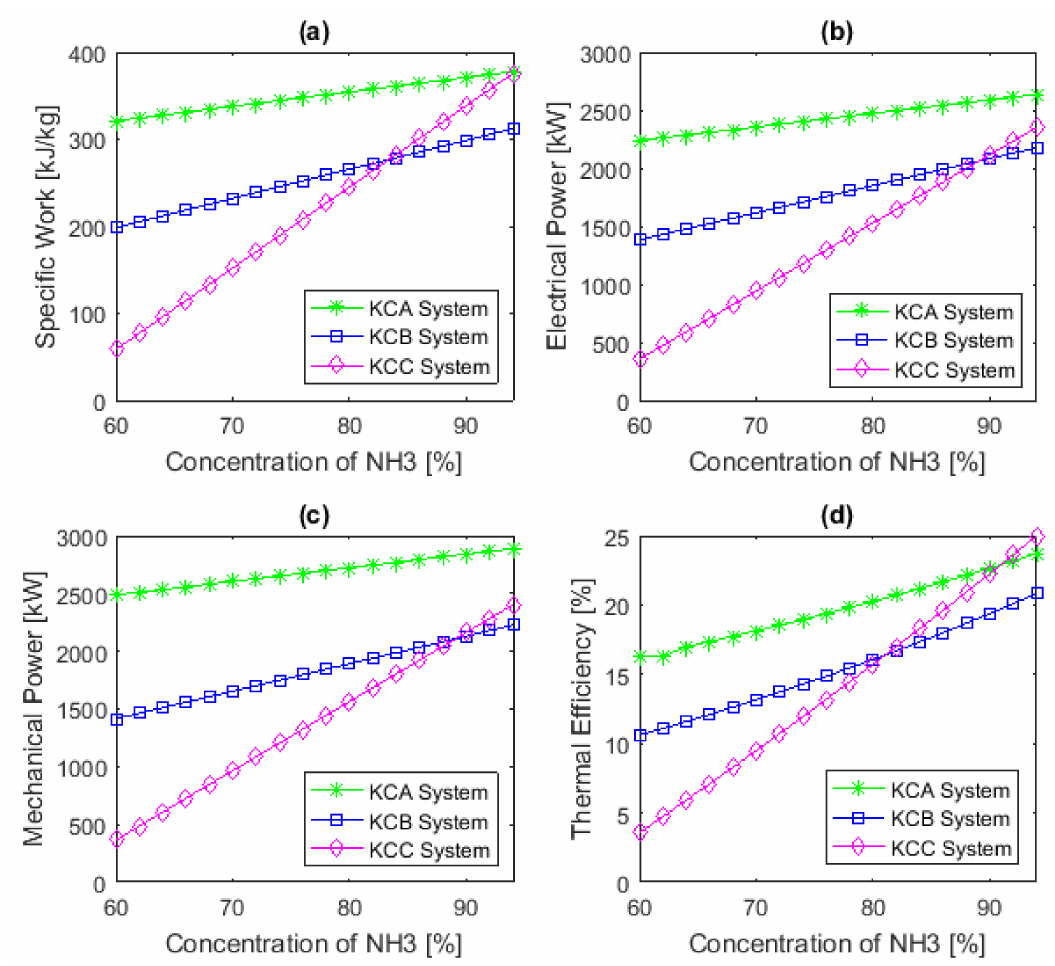
Figure 9. Effect of NH 3 concentration on the: ( a ) specific performance, ( b ) electrical power, ( c ) me- chanical power, and ( d ) thermal